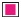
The shaded ■ area, site Z-7L of 12 ha, demarcated for wide area Bti spray treatment.A low lying riverine site, 500 meters from Rajang River. In Zone 5 and in Zone 14 the wide area Bti spray treatments were not conducted.